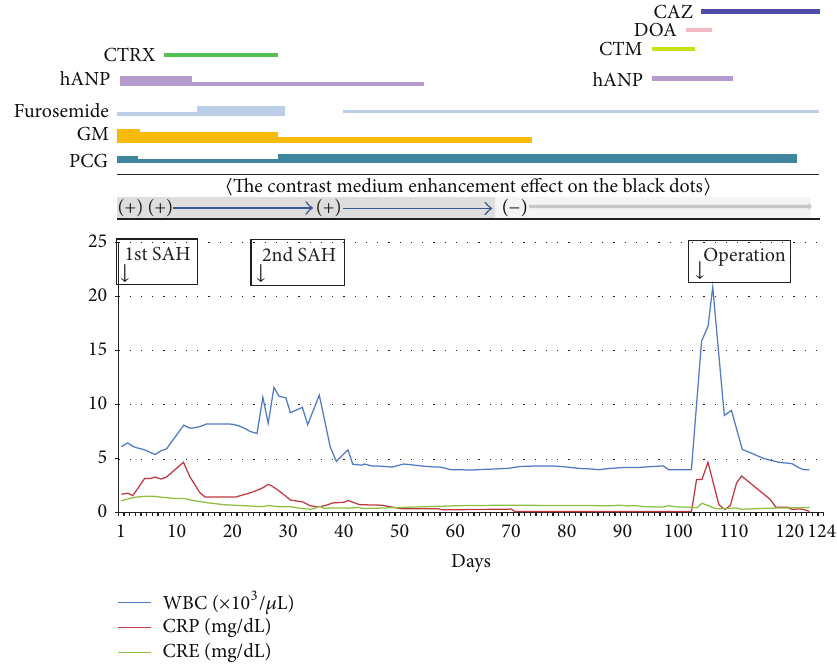
Figure 1: Clinical course. hANP = human atrial natriuretic peptide, GM = gentamicin, PCG = penicillin, SAH = subarachnoid hemorrhage, CTRX = ceftriaxone, CAZ = ceftazidime, DOA = Dopamine, and CTM =